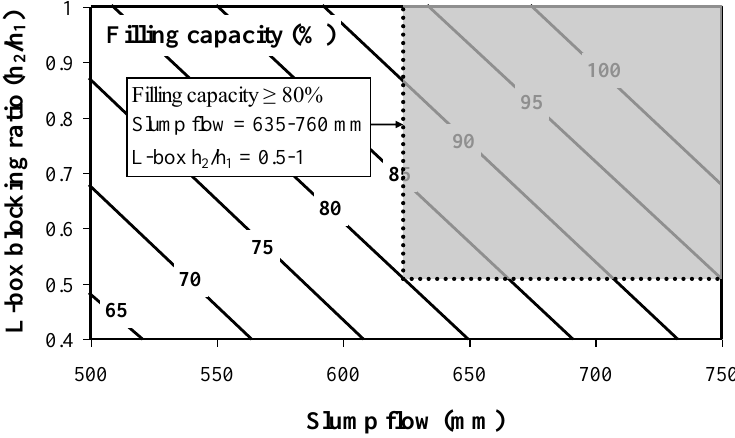
Figure 1. Contour diagrams between filling capacity, slump flow, and L-box blocking ratio determined at 10 min (R 2 = 0.82) (Equation